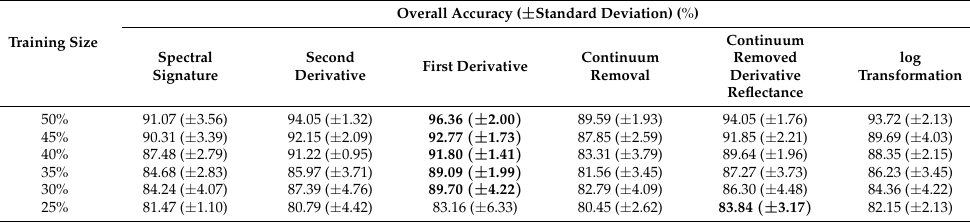
Table 21. Vegetation types identification accuracies (overall accuracy ( ± standard deviation) in %) on [350–1350 nm] for RLR- (cid:96) 2